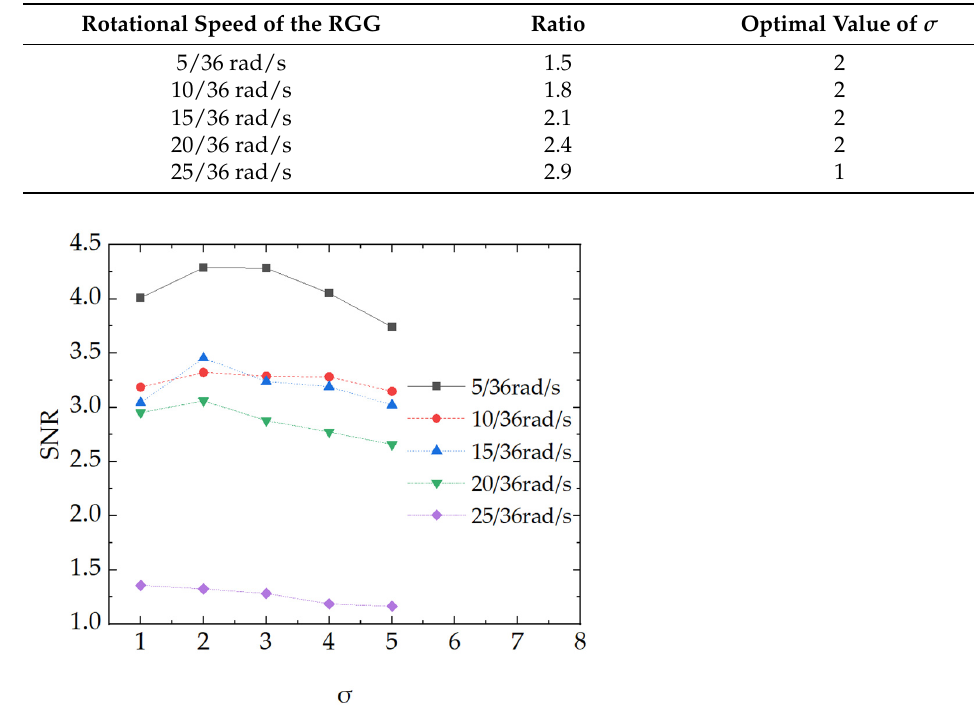
Figure 9. The SNR of the reconstructed image of the SC with the Hessian matrix in different values of standard deviation at different rotation speeds of the RGG.